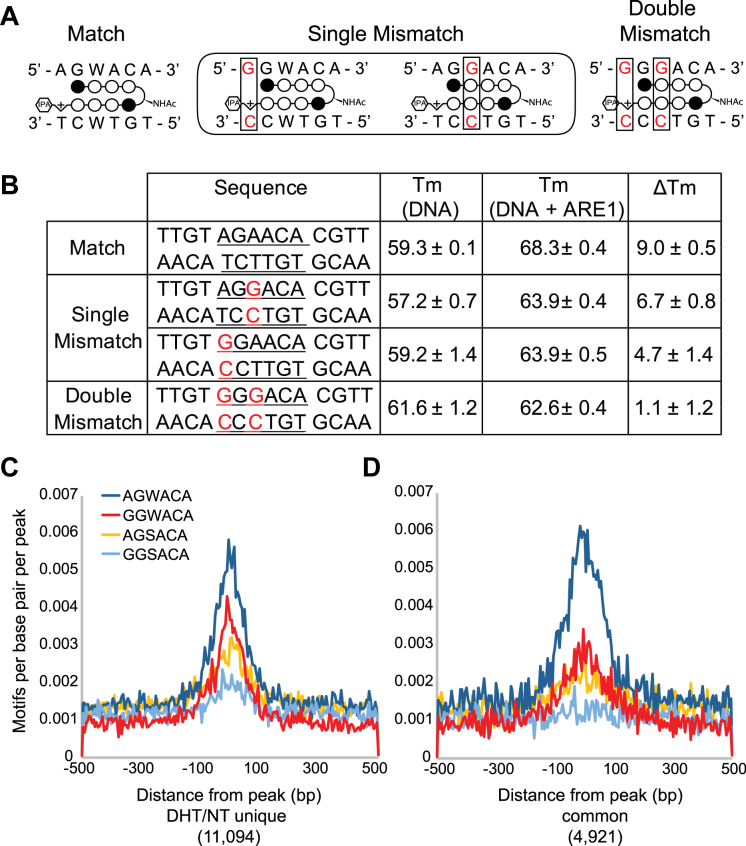
(A) Illustration of match and mismatch ARE-1 binding sites. Mismatches are shown in red and boxed. (B) Melting temperature analysis of match and mismatch sequences shown in A. C + D) Motif density analysis of possible ARE half sites in peaks unique to DHT/NT (C) and overlapping between DHT/NT and DHT/DHT + ARE-1 (D).